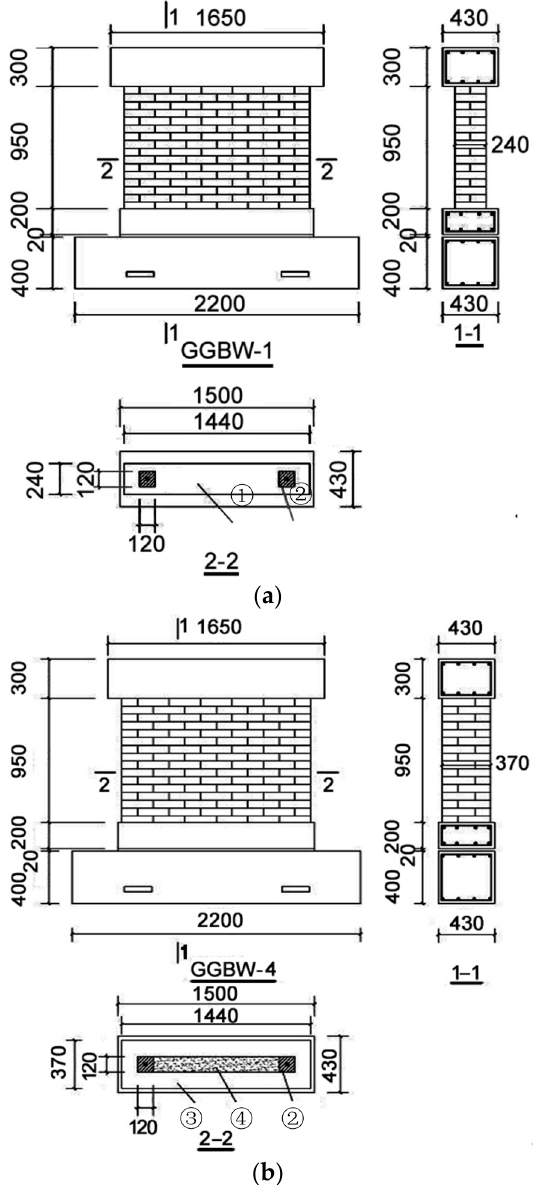
Figure 4. Example specimen diagrams ( a ) Glass ‐ Graphite –Base ‐ Wall ‐ 1 (GGBW ‐ 1); ( b ) GGBW ‐ 4; ( ① ‐ clay bricks; ② ‐ concrete stem; ③ ‐ recycled bricks; ④ ‐ flay ash blocks).